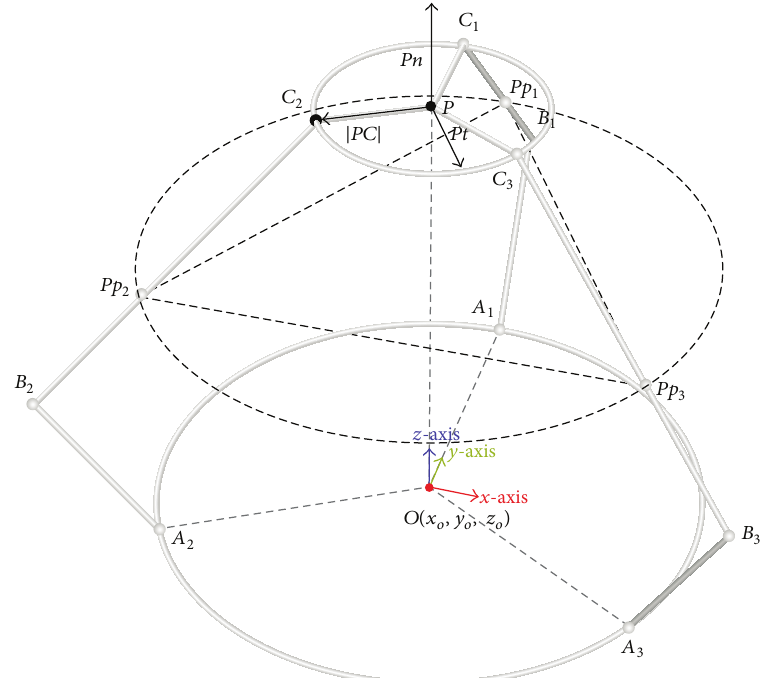
Figure 5: Cabri 3D geometrical model of micromanipulator with vector 𝑃𝐶 connected in point 𝑃 with the moving